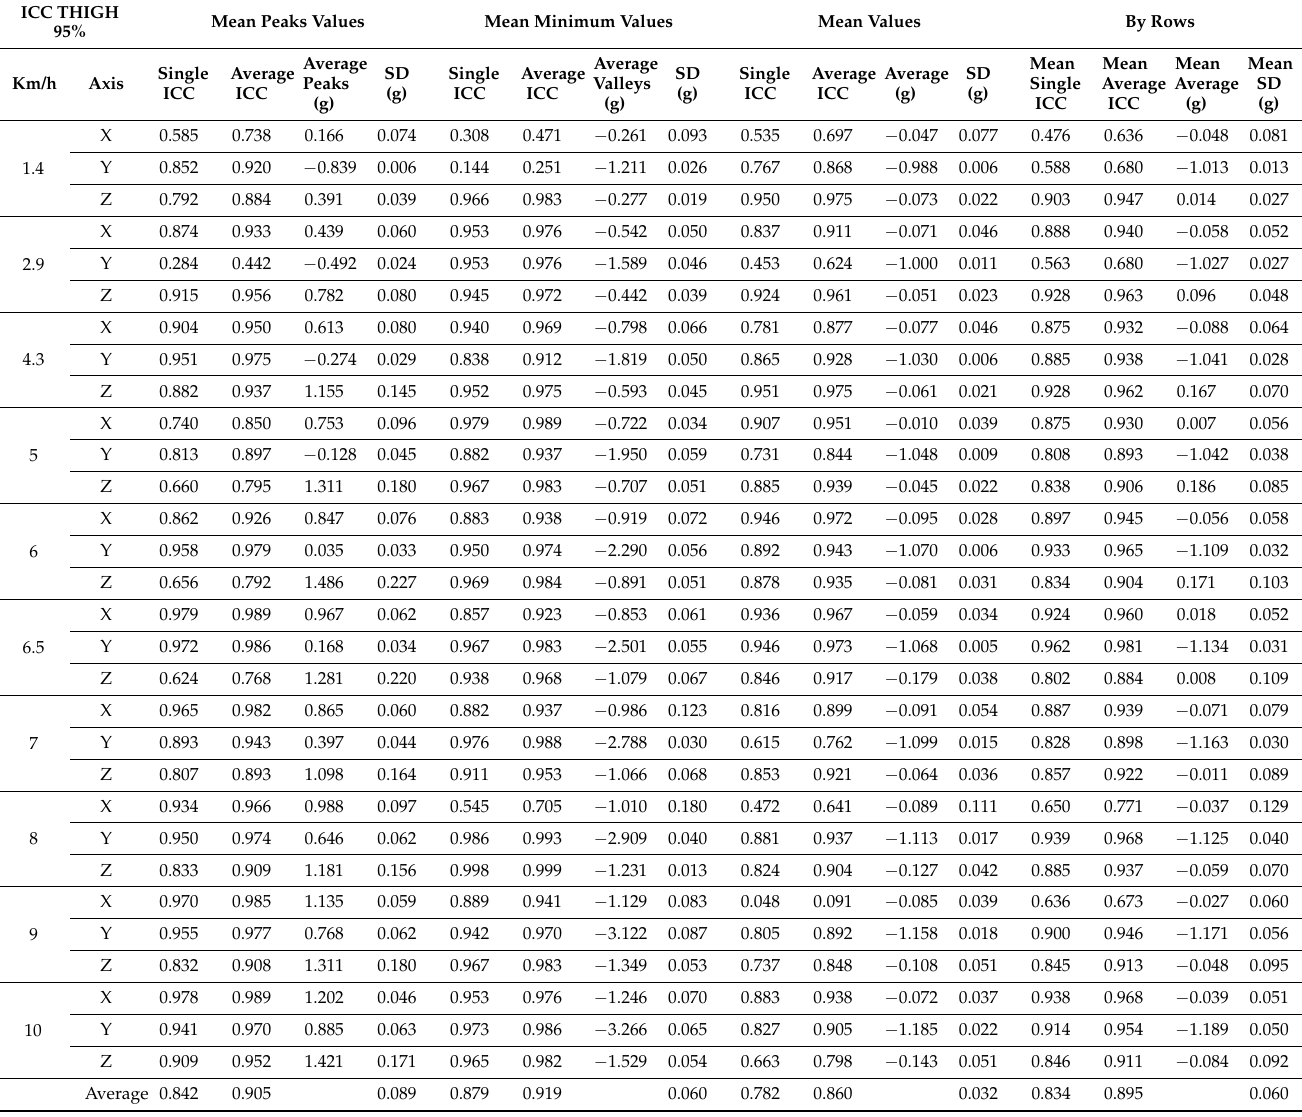
Table 2. ICC values and standard deviation grouped by speed (km/h) and axis, in thigh